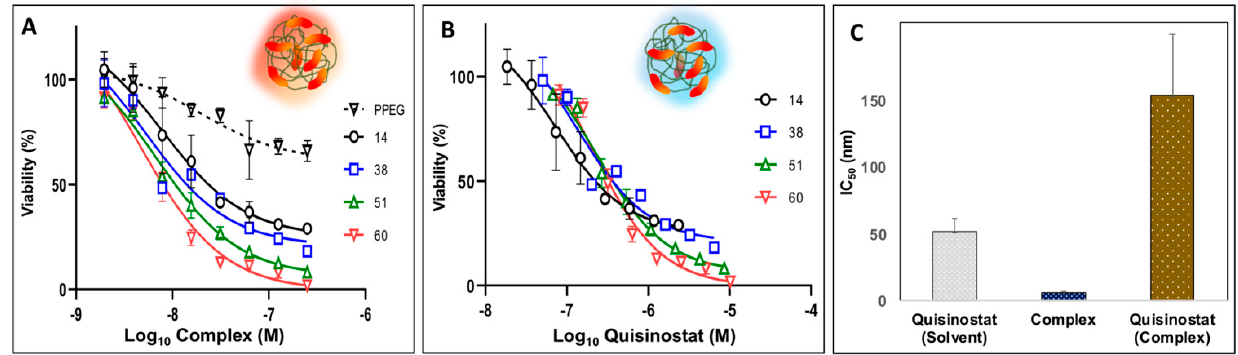
Figure 5. Potency of quisinostat-PPEG complexes in WM115 human melanoma cell viability experiments: ( A , B ) Dose–cell viability curves for quisinostat-PPEG complexes and PPEG plotted as a function of complex/polymer ( A ) or quisinostat ( B ) concentrations (numbers indicate quisinostat to polymer ratios in the complexes (mol/mol)); ( C ) half maximal inhibitory concentrations (IC 50 ) calculated relevant to concentrations of quisinostat formulated in DMSO-water mixture (“quisinostat-solvent”), concentration of entire complex containing multiple quisinostat molecules (“complex”—panel ( A ) data, average), and individual quisinostat molecules in a complex—“quisinostat-complex”—from panel ( B ) data (72 h, n = 3; points represent the mean values with errors indicating standard deviation; respective IC 50 values, 95% confidence intervals of IC 50 values, and goodness of fit (R 2 ) of individual curves are shown in Appendix B, Tables A3 and A4).